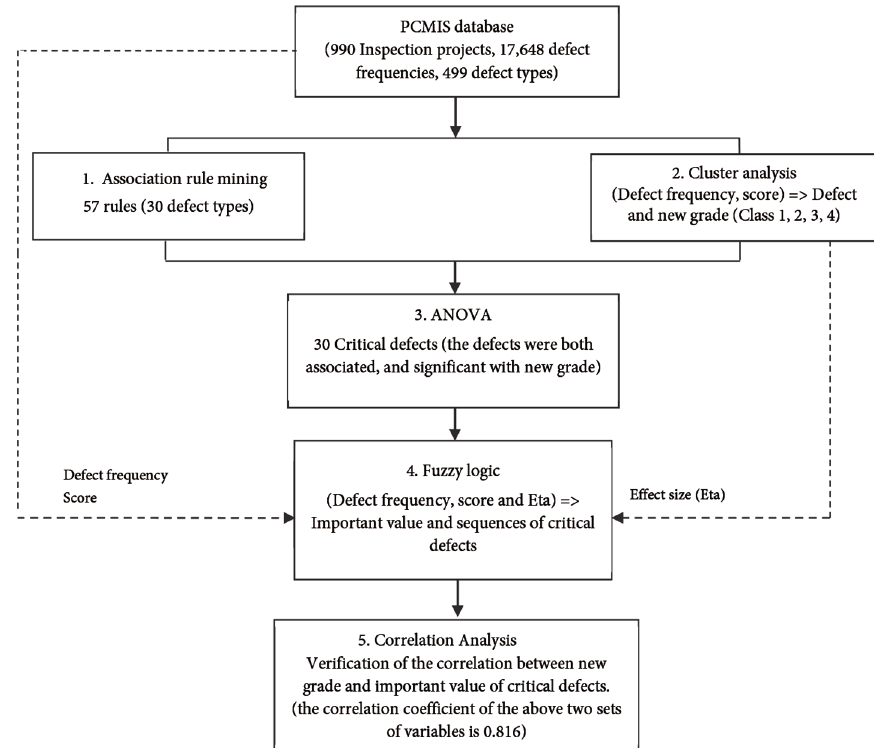
Figure 1. Research